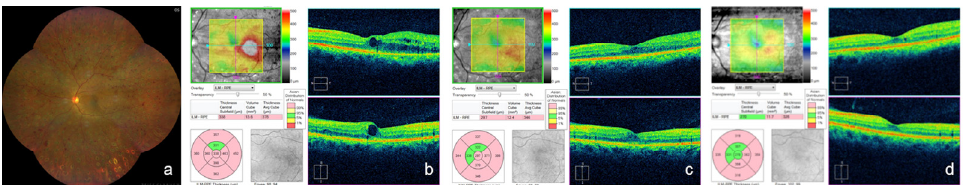
Figure 2. Changes in the mean central retinal thickness following the intravitreal faricimab injection.